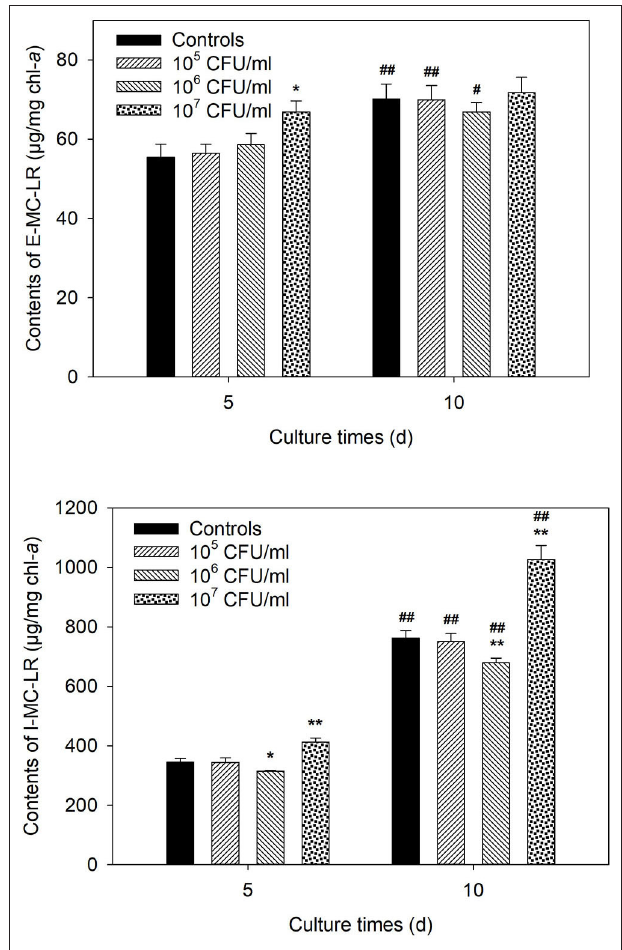
FIGURE 4 | Influences of strain JXJ CY 35 T on the E-MC-LR and I-MC-LR of Maf at different inoculation dosages. *, ** Indicate the significant differences between the control and the tests inoculated with different dosages of strain JXJ CY 35 T at the levels of P < 0.05 and P < 0.01. #, ## Indicate the significant differences between days 5 and 10 of culture at the levels of P < 0.05 and P <